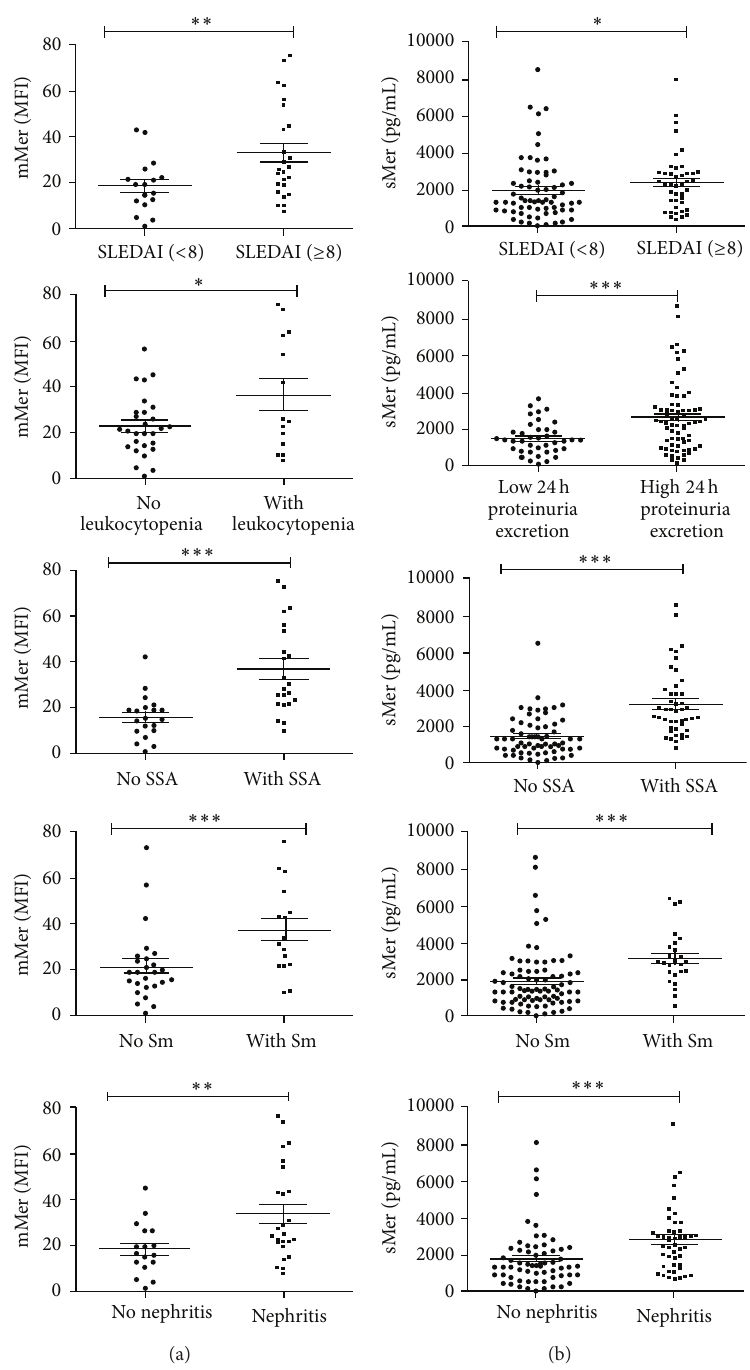
Figure 4: mMer and sMer levels according to the clinical manifestations in SLE. (a) mMer expression on CD14+ monocytes/macrophages in patients with a SLEDAI more than orequal to 8, WBCless than 4×10 9 /L, and with SSA, Sm or lupus nephritis. (b) Plasma sMerconcentrations in patients with a SLEDAI more than or equal to 8, 24 h proteinuria excretion more than or equal to 0.1g/d, and with SSA, Sm or lupus nephritis. SLEDAI = SLE disease activity index. WBC: leukocytes; SSA: anti-SSA antibody; Sm: anti-Sm antibody. Circles in solid and in blank represented the mMer or sMer levels in the presence and absence of manifestations in SLE with the studied parameters, respectively. Horizontal lines above dots showed difference. ∗ 𝑃 < 0.05 , ∗∗ 𝑃 < 0.01 , ∗∗∗ 𝑃 < 0.001